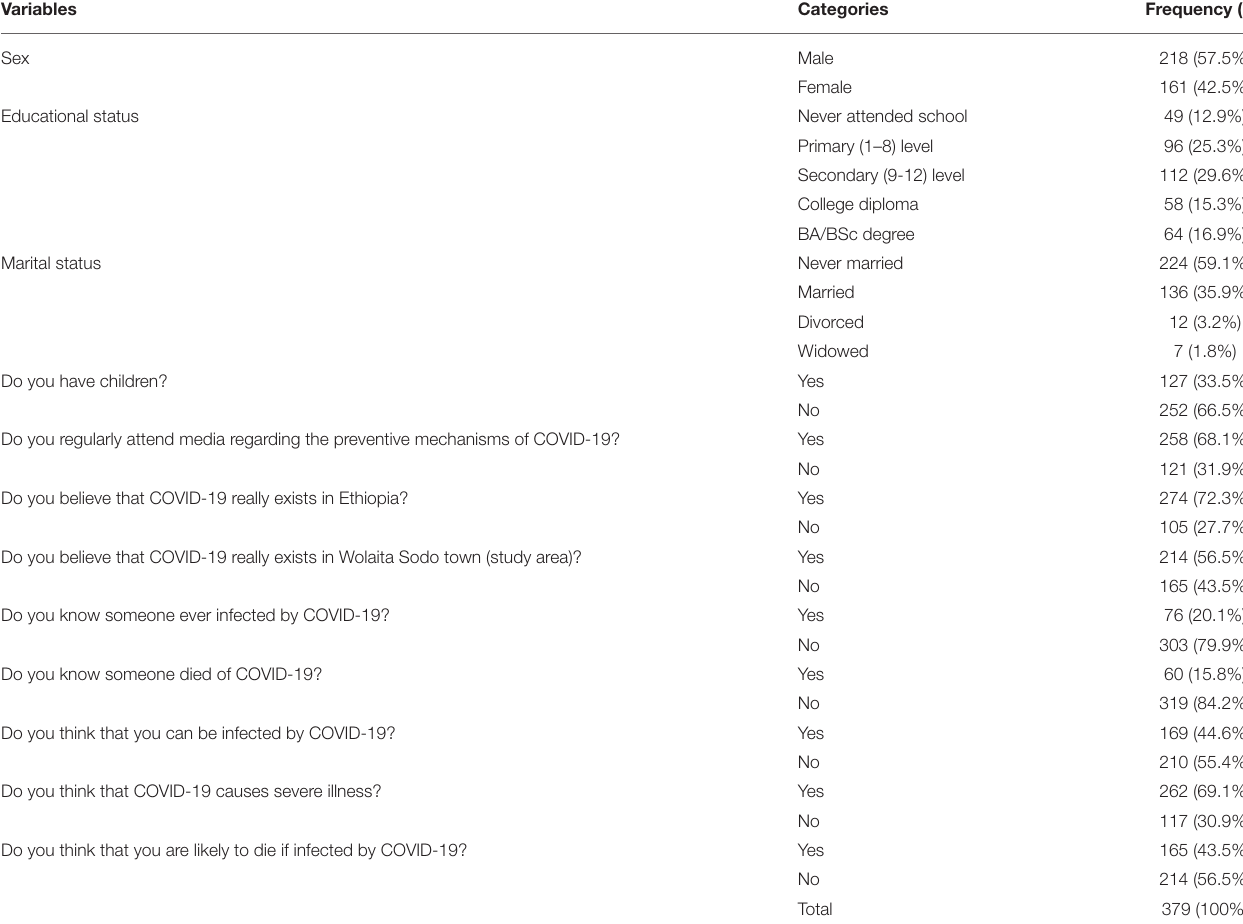
TABLE 1 | Socio-demographic background of